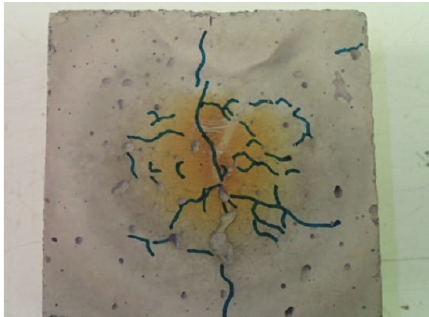
Figure 7: Detail of surface after heating with marked cracks, speci- men CEM III/B - B-PF.